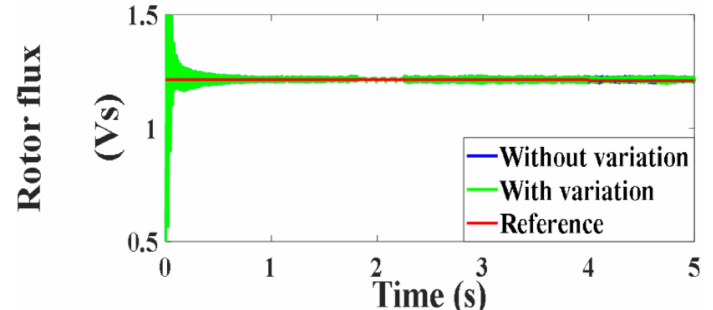
Figure 82. Rotor flux under PVC (Vs).